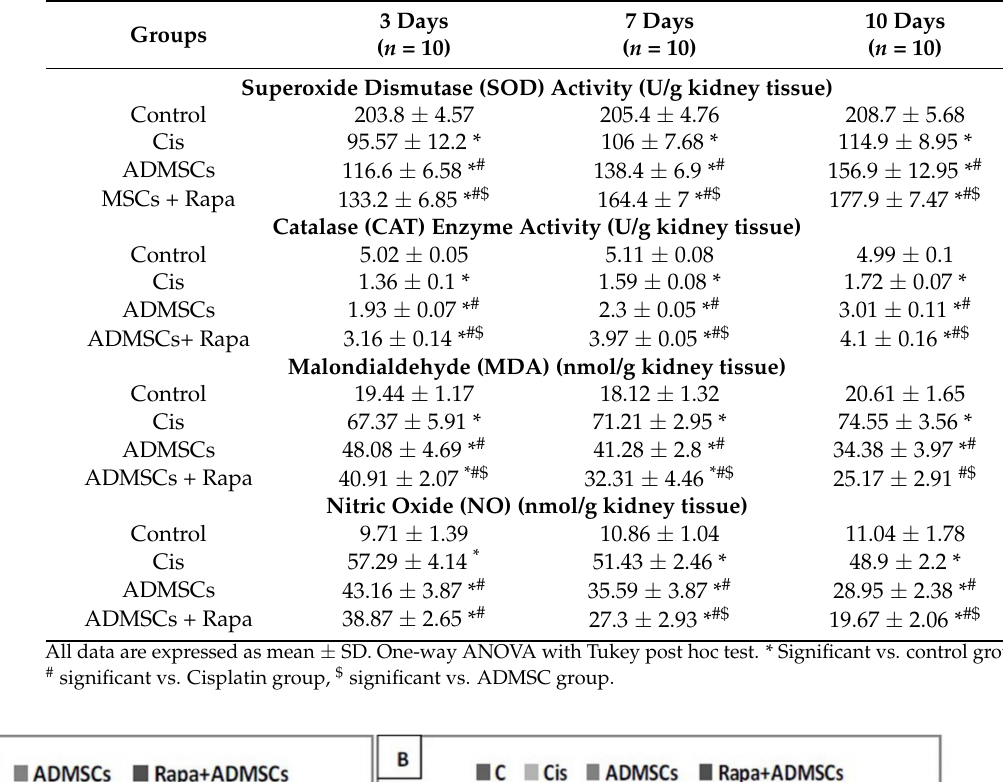
Table 3. Effects of MSCs pretreated with rapamycin on oxidative stress/antioxidant levels at 3, 7 and 10 days after cisplatin induction.